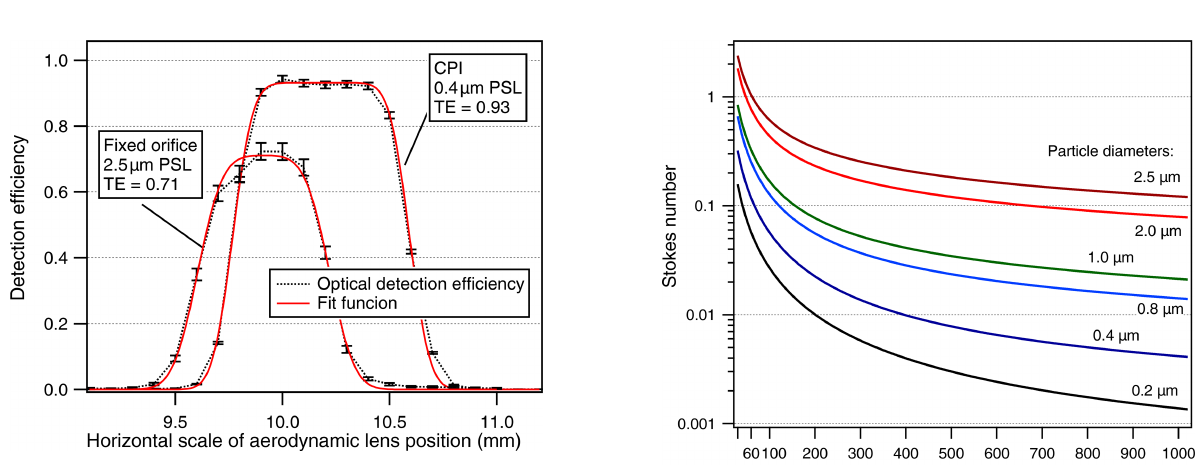
Figure 6. Two examples of detection efficiency measured by step- ping the particle beam across a detection laser (and photomulti- plier unit). Detection efficiency was calculated from photomulti- plier counts of the optical detection stage normalized by external CPC or OPC concentration. Total particle transmission efficiency (TE) is obtained as a parameter of a fit function, which results from a convolution of the assumed Gaussian particle beam profile, and a rectangular function describing the detection threshold.